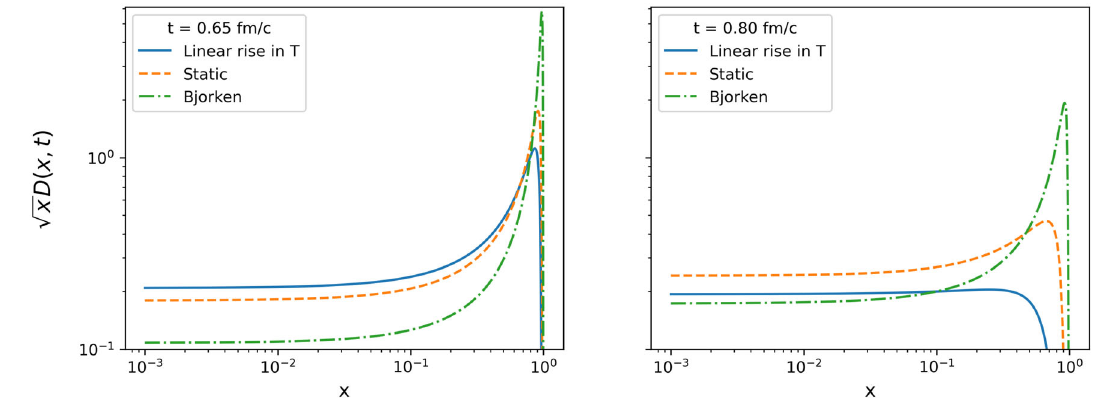
√ Fig. 1 Graph of xD o ( x , t ) for the three cases: static, Bjorken (isentropic) expansion and linear rise in T , at different values of t